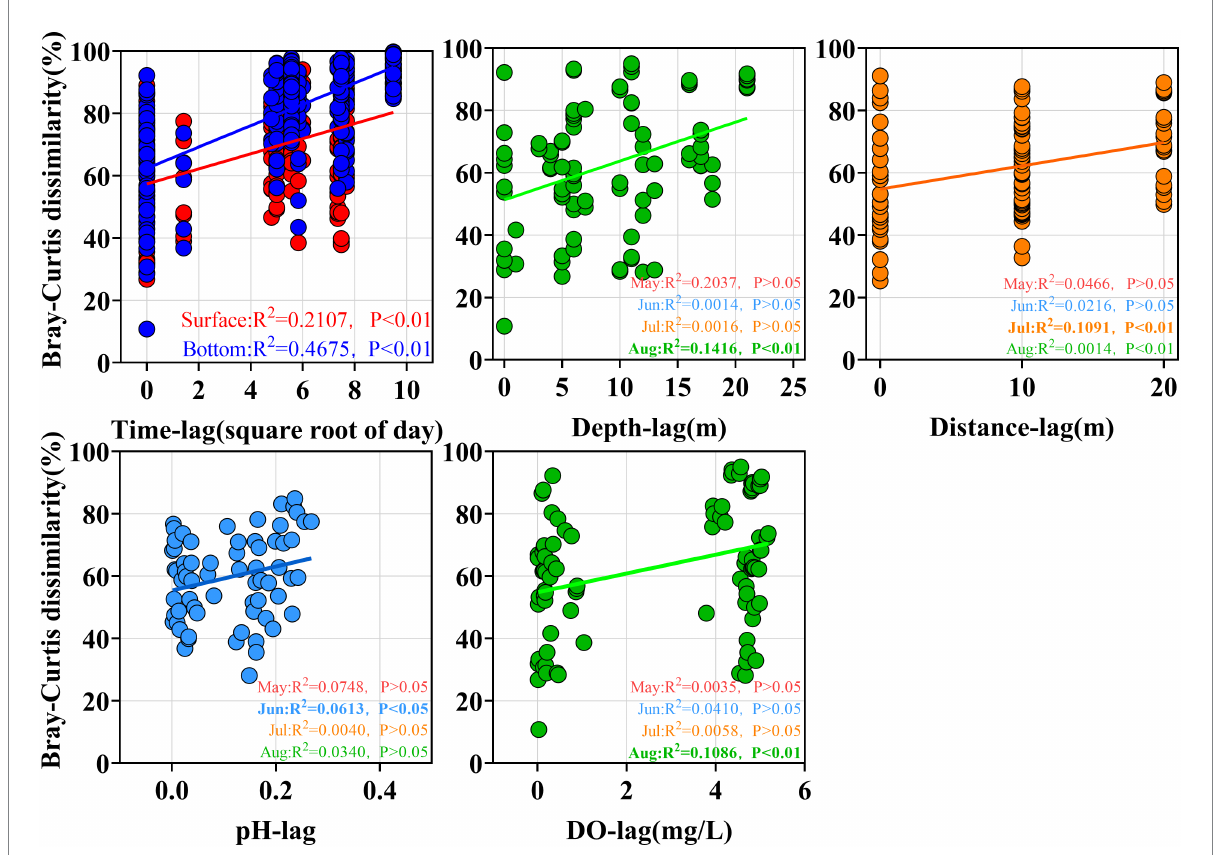
FIGURE 5 Regression analysis of Bray-Curtis differences for different pathogenic bacterial